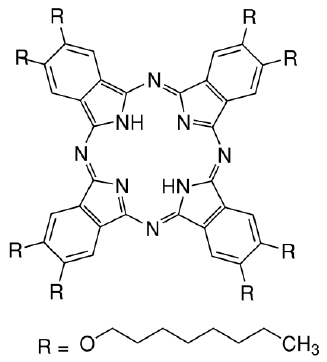
Figure 1 Molecular structure of H